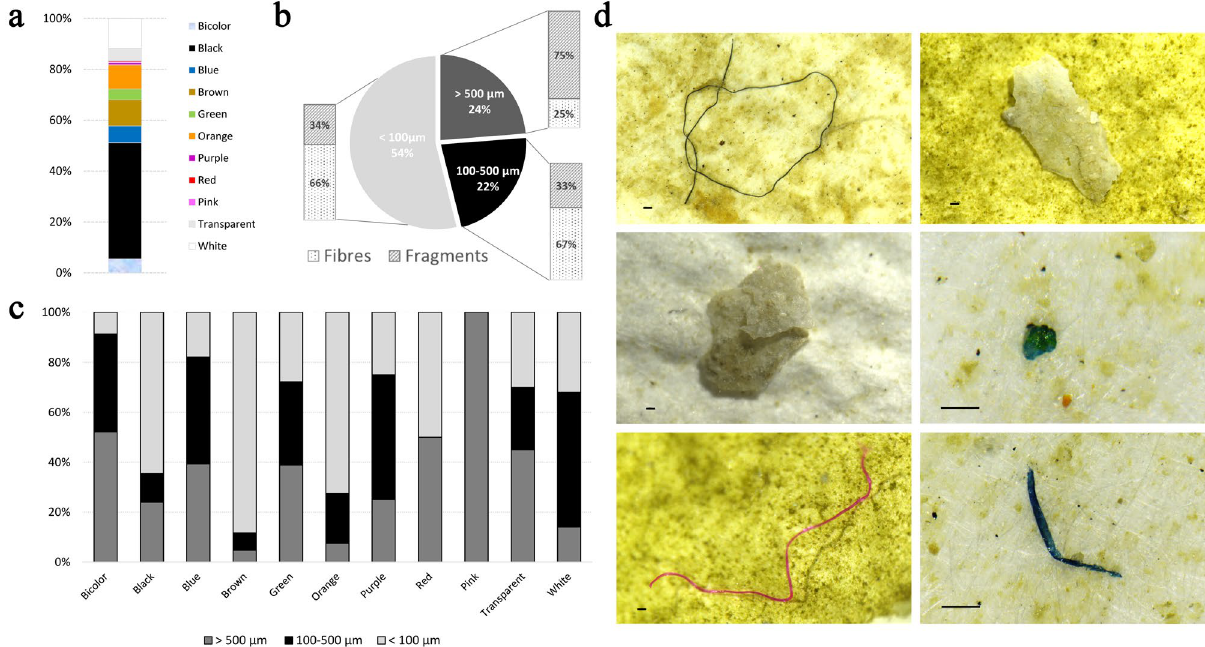
Figure 4. Relative abundance (%) of microplastics detected on glass microfibre filters after digestion and filtration of gastrointestinal tracts of six Nudibranchia and classified according to ( a ) colour; ( b ) size and shape and ( c ) size for each colour; ( d ) images observed by stereomicroscope of different shapes of MPs found in specimens. Scale bar = 100 μm.